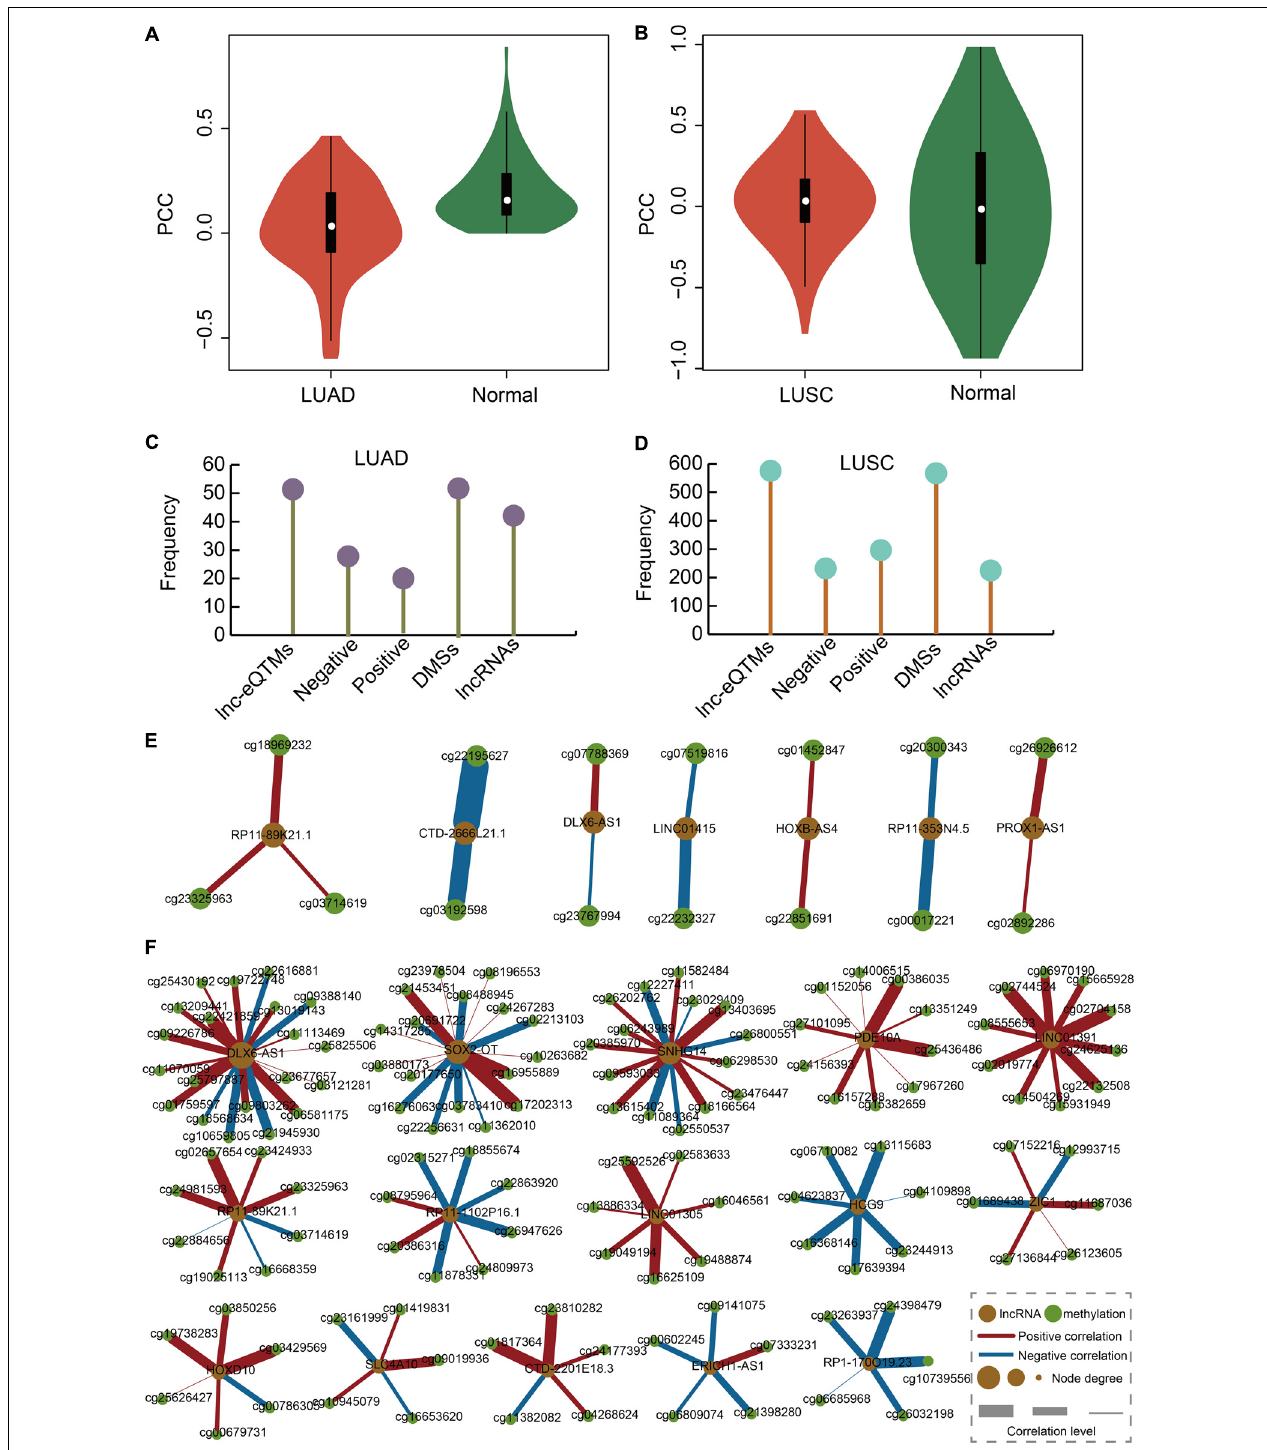
FIGURE 2 | Construction of LUAD- and LUSC-specific lnc-eQTM networks. (A) Violin plot showing PCCs between DMSs and corresponding DMSmlncRNAs in LUAD and normal tissues. (B) Violin plot showing PCCs between DMSs and corresponding DMSmlncRNAs in LUSC and normal tissues. (C) Lollipop graph showing the number of lnc-eQTMs, negative lnc-eQTMs, positive lnc-eQTMs, DMSs, and lncRNAs in LUAD. (D) Lollipop graph showing the number of lnc-eQTMs, negative lnc-eQTMs, positive lnc-eQTMs, DMSs, and lncRNAs in LUSC. (E) LUAD-specific network. Orange and green represent lncRNA and methylation sites; red and blue edges represent positive and negative interactions; and thicker edges and bigger nodes represent stronger interactions and higher degrees, respectively. (F) LUSC-specific network.